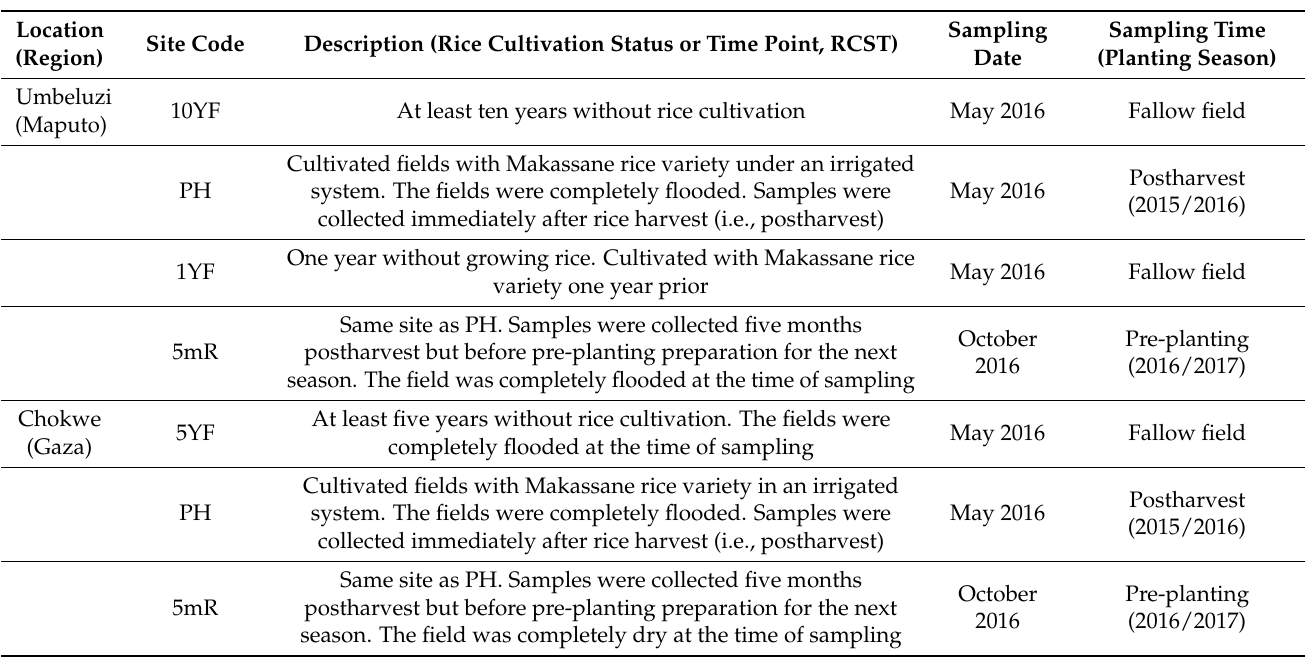
Table 1. Study site